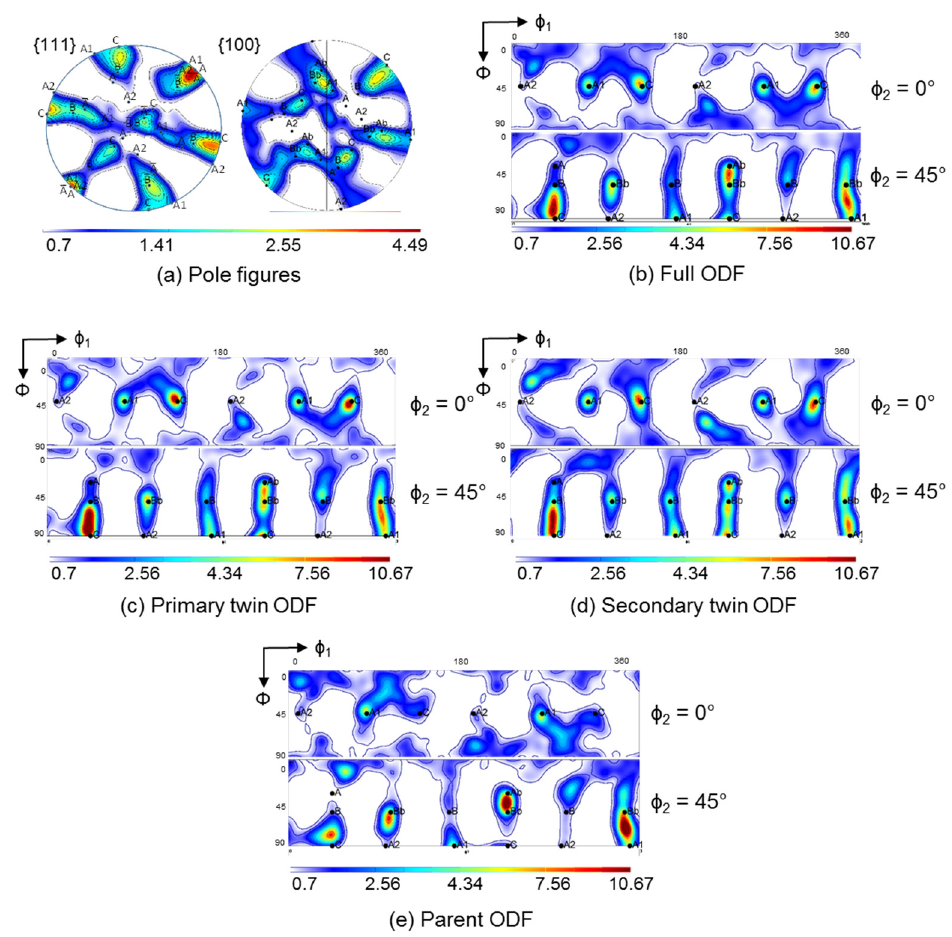
Figure 8. Simulated texture after one ‐ pass ECAP obtained by the Taylor model without twinning in {111} and {100} pole figures as well as in the φ 2 = 0° and 45° ODF sections.